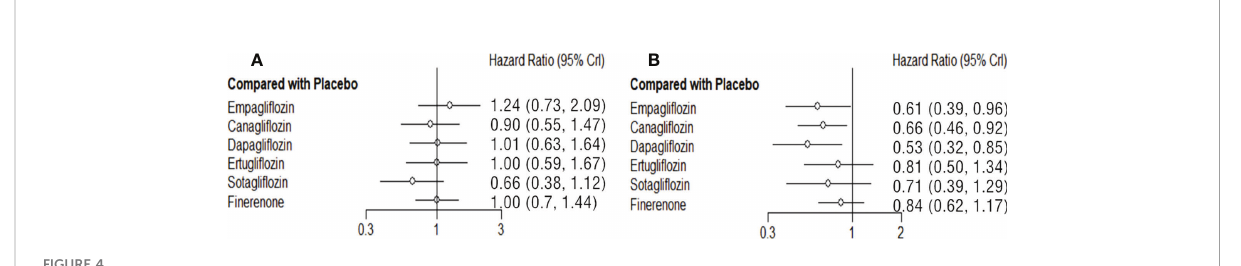
FIGURE 4 Comparison between the ef fi cacy of SGLT2i and fi nerenone and placebo on NS (A) and RCO (B)